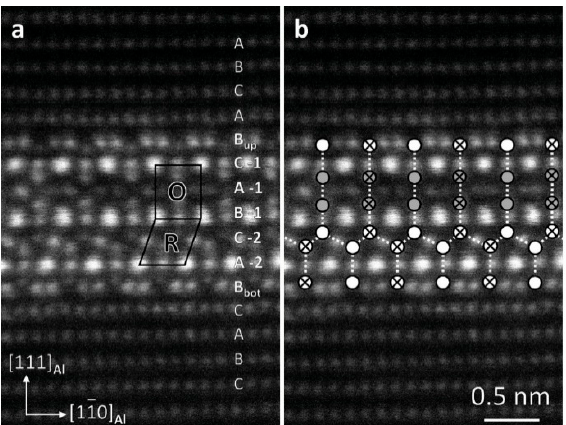
yellow dashed frame in (i); ( h ) is the corresponding inverse FFT image of ( e ), and; ( i ) is from the white solid frame in (h). Adapted with permission from ref. [55]. 2021 Zang et al.